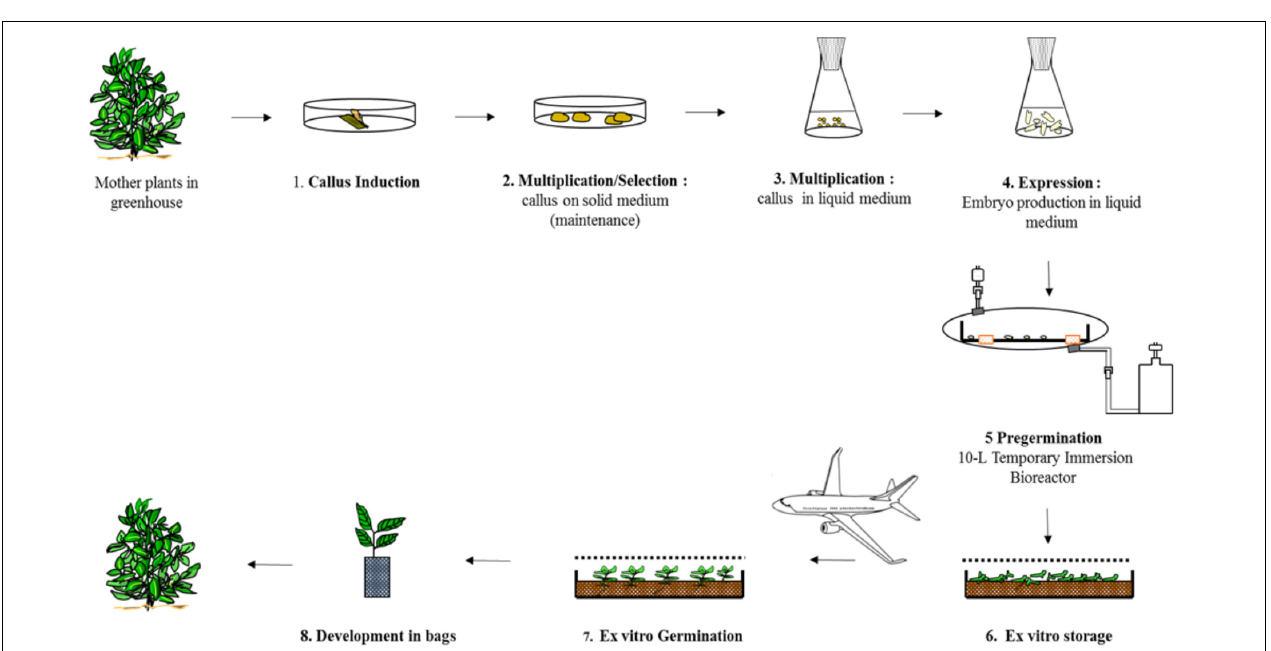
FIGURE 7 | Notion of the “balance” and the effects of some factors on reaching the required equilibrium for the formation of embryogenic callus.